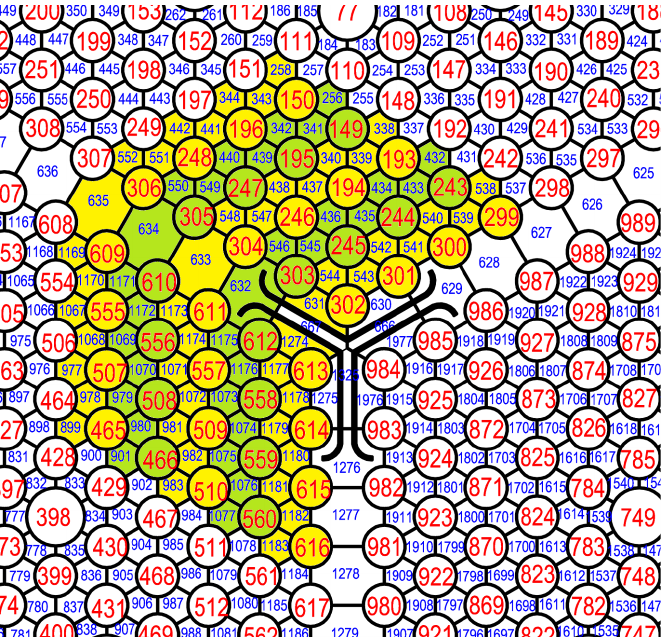
Figure 5. Areas of evaluation of lateral coolant flow and coolant temperature around